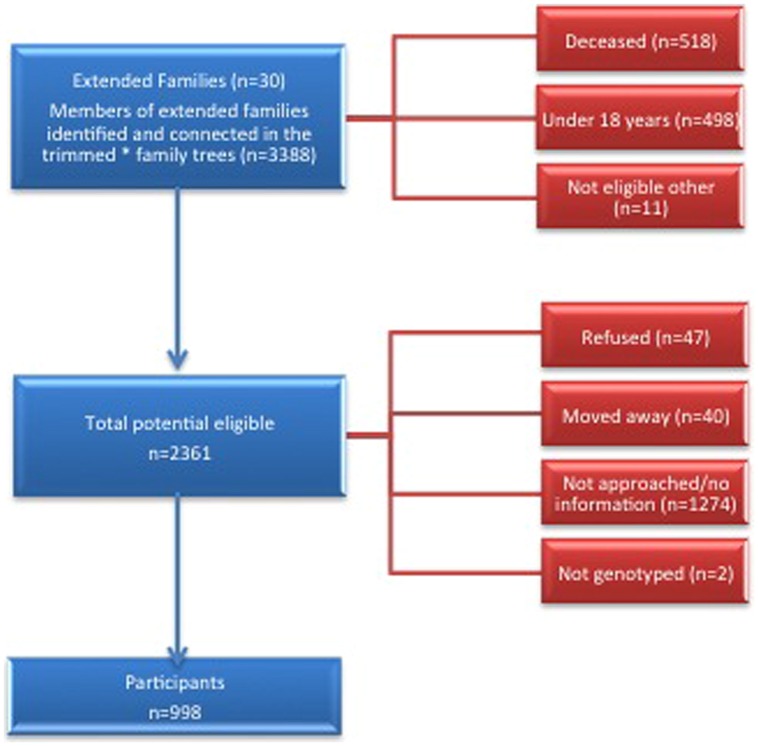
Study participants, flow diagram.